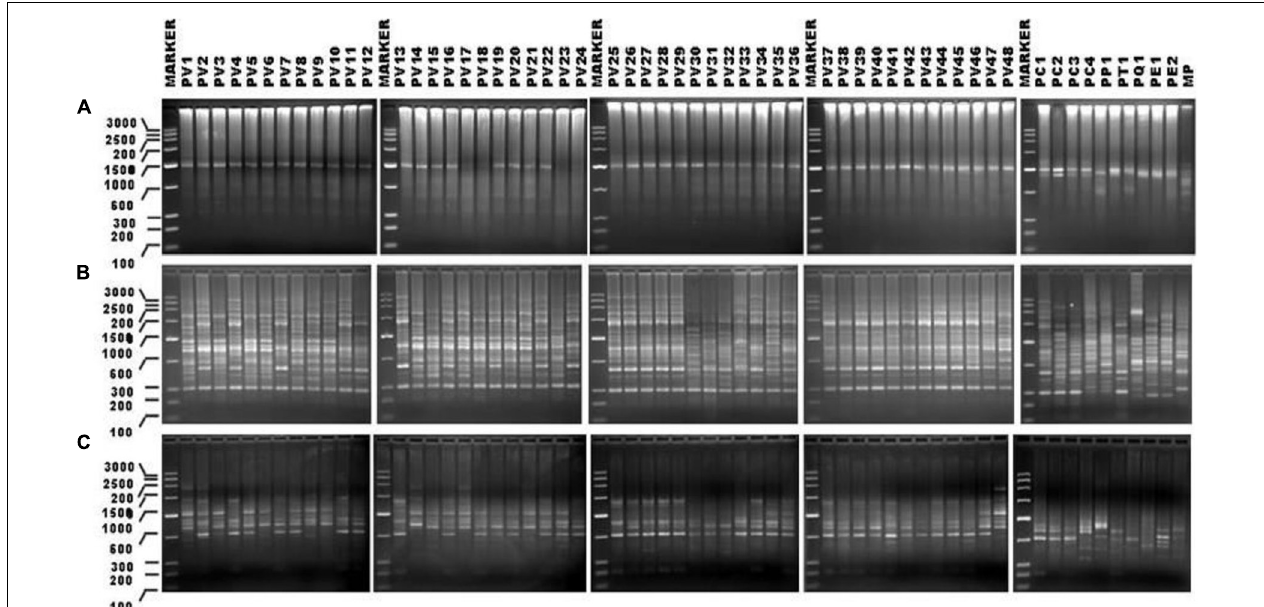
FIGURE 2 | SPAR profile obtained in case of 57 genotypes of Pteris DNAs with the ISSR primer UBC-825 (A) ; PAMD primer HVR (B) , and RAPD primer OP-H02 (C) . The Lines are marked with sample names as abbreviated in Table 1 . The lanes where DMA molecular size marker (Low Range Rnlei) was loaded are marked as MARKER. Sizes of the marker fragments (in bp) are indicated on the scale to the left of the first gel image in all three panels. All agarose gels for the profiles are 1.2% (w/v) in TBE